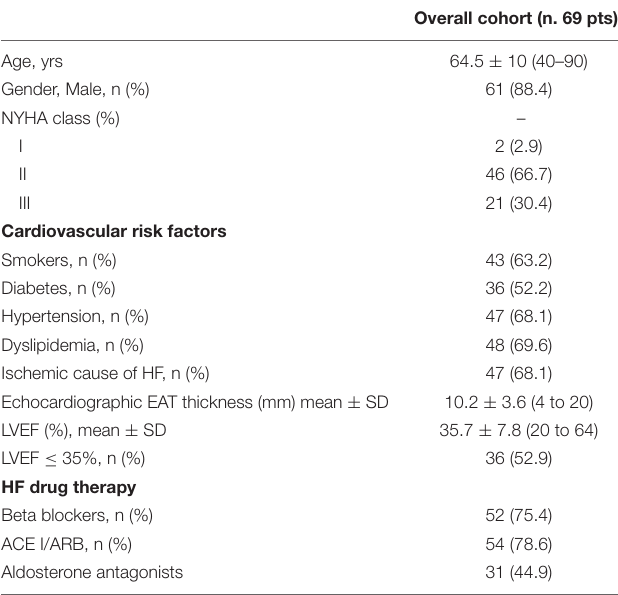
TABLE 1 | Demographic and clinical data of the study population.